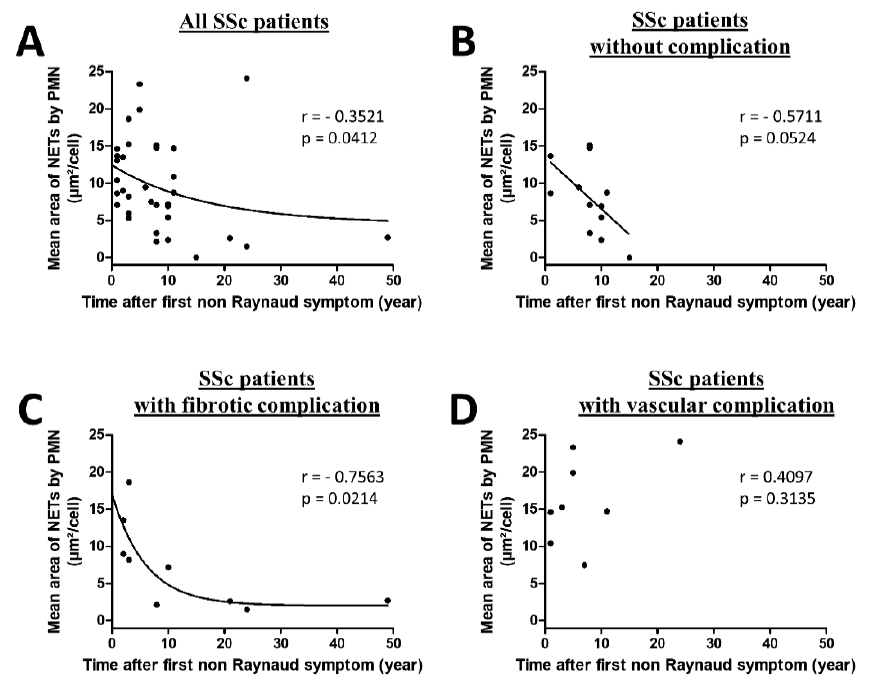
Figure 5. NETosis phenomenon is an early process occurring in SSc patients that persists in patients with vascular complications. ( A ) PMN from patients were stimulated with autologous sera to assess the correlation between mean area of NETs by PMN and time after the first non-Raynaud’s phenomenon symptom. All stimulations (n = 34) were performed in duplicate. ( B – D ) Due to a link between the type of complication and quantity of NETosis, results were analyzed according to the type of complication. In each case, PMN from patients was stimulated with autologous sera to assess the correlation between mean area of NETs by PMN and time after the first non-Raynaud’s phenomenon symptom ( B ) without complication (n = 12), ( C ) fibrotic complications (n = 9), and ( D ) vascular complications (n = 8). Each dot represents the mean area of NETs by PMN of two similar experiments. The regression curves concerning all patients ( A ) and patients with fibrotic complications ( C ) were obtained using a one phase exponential decay nonlinear regression with the following equations respectively: Y = (12.45–4.519) × exp( − 0.05926X) + 4.519; Y = (17.06–2.028) × exp( − 0.1677X) +